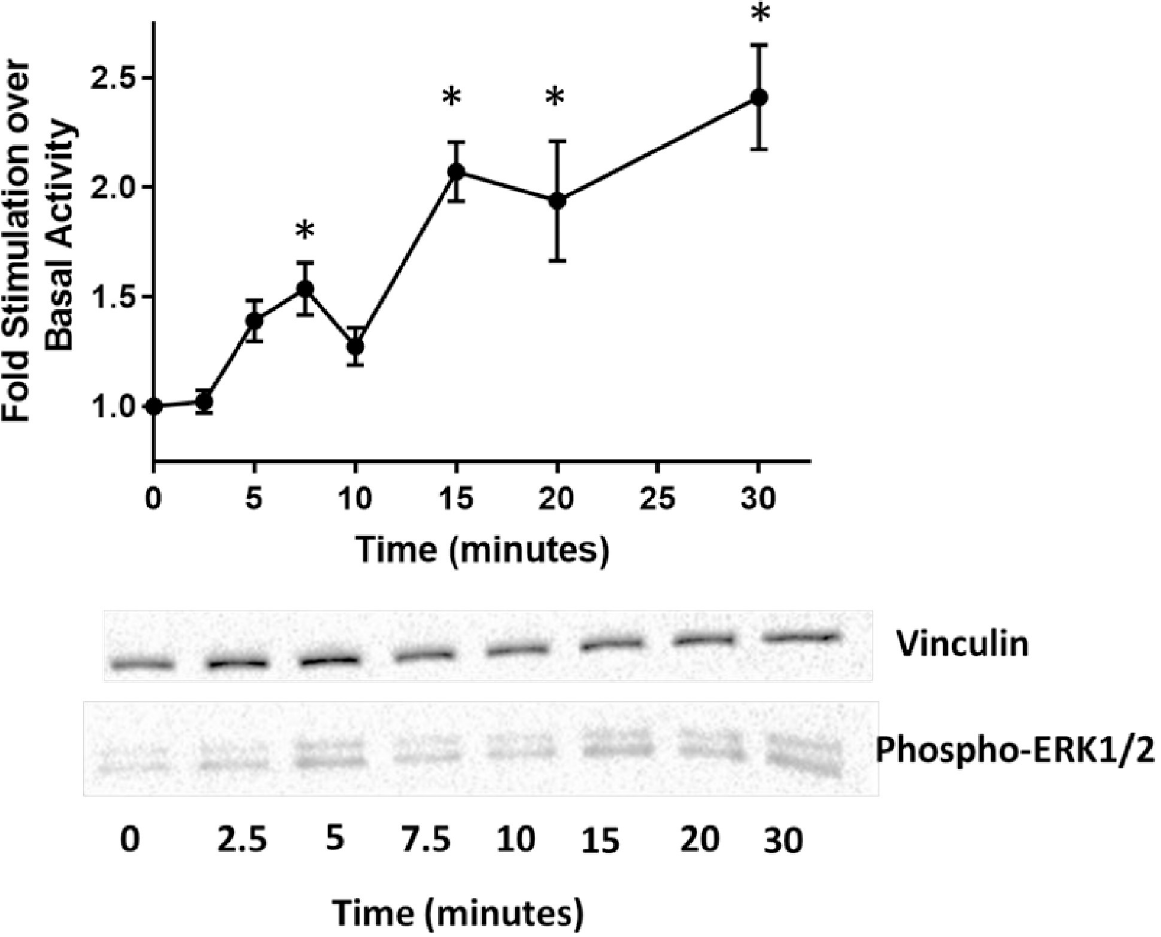
Fig 5. ERK1/2 Phosphorylation profile. In the HUVEC line PN5 that expresses NOP receptors in the absence of LPS/PepG treatment, addition of 1 μ M N/OFQ leads to stimulation of ERK1/2. Representative Western blots are shown below the graph. Data are the mean ± SEM of 5 separate experiments. Analysis was undertaken on raw data using ANOVA and Bonferroni post hoc analysis, � statistically greater than raw basal activity (p < 0.05).